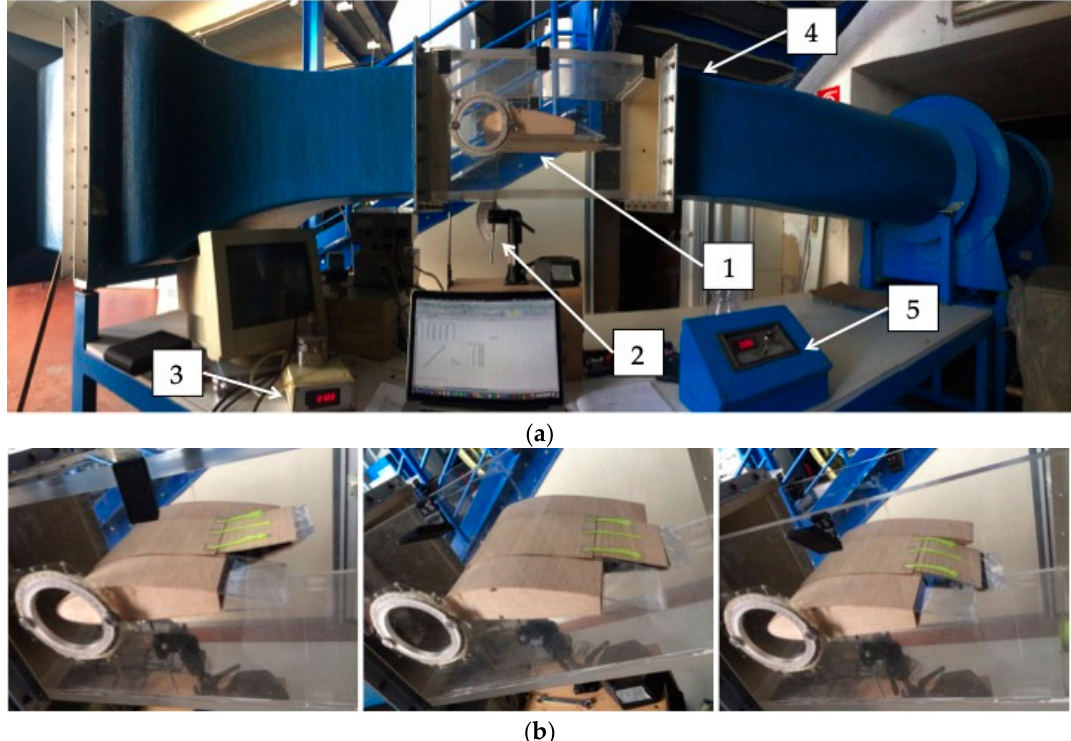
Figure 16. Wind tunnel experiment: ( a ) 1. Sample profile with discrete mobile surface, 2. angles of attack (AOA) tool (min − 15°, max +20°), 3. pitot tube, 4. test chamber and 5. wind speed regulator and ( b ) negative (LEFT), neutral (CENTRE) and positive (RIGHT) deflection of discrete mobile surface.